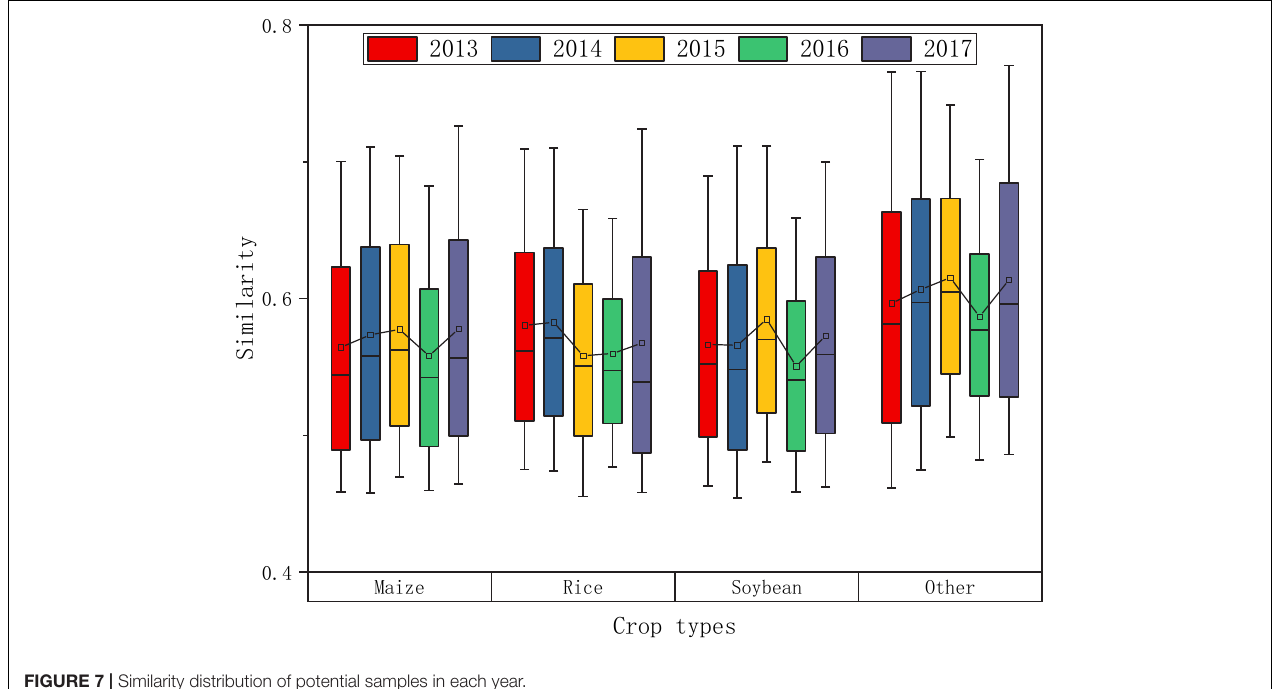
FIGURE 7 | Similarity distribution of potential samples in each year.